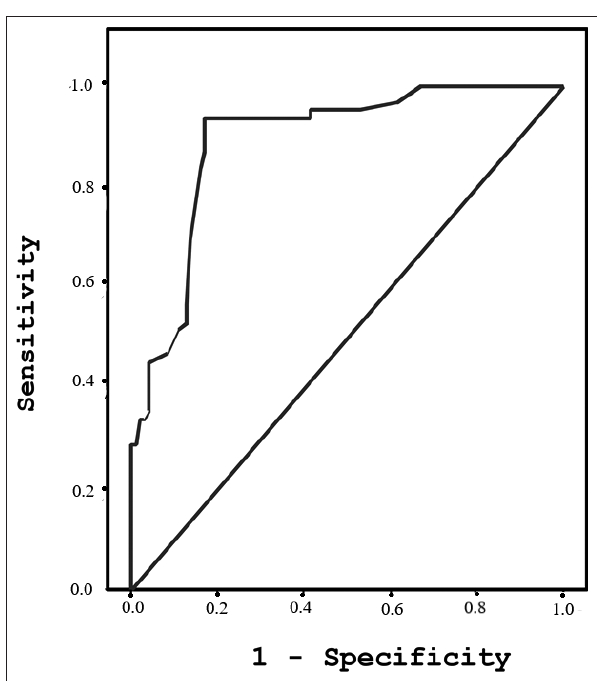
Figure-3: Area under the receiver operating characteristic curve for diagnostics of Fasciola gigantica against all samples from cattle (area under curve=0.89;